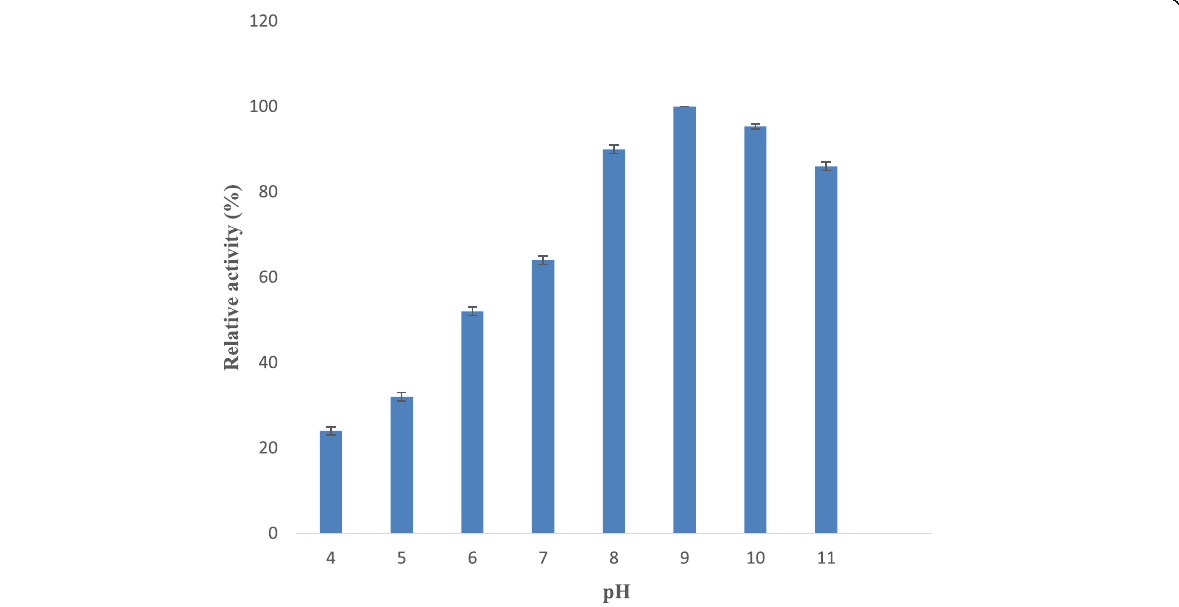
Fig. 3 Effect of pH on serratiopeptidase activity. The enzyme activity was measured at various pH (4 to 11) using a standard assay method. Each value represents the mean ± SD for three